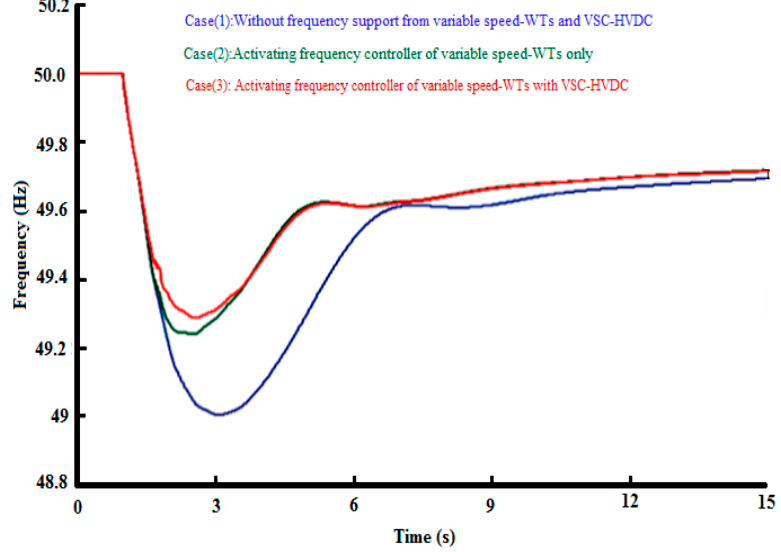
Figure 22. Different frequency response in the previous three cases: case (1): Without frequency support from variable speed-WTs and VSC-HVDC, case (2): Activating frequency controller of variable speed-WTs only and case (3): Activating frequency controller of variable speed-WTs with VSC-HVDC.